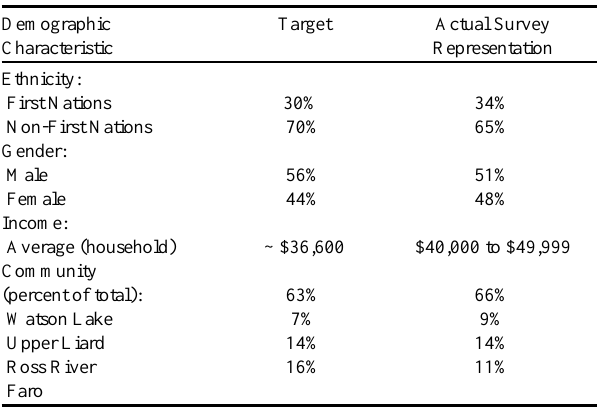
Table 2 . Demographic characteristics of the